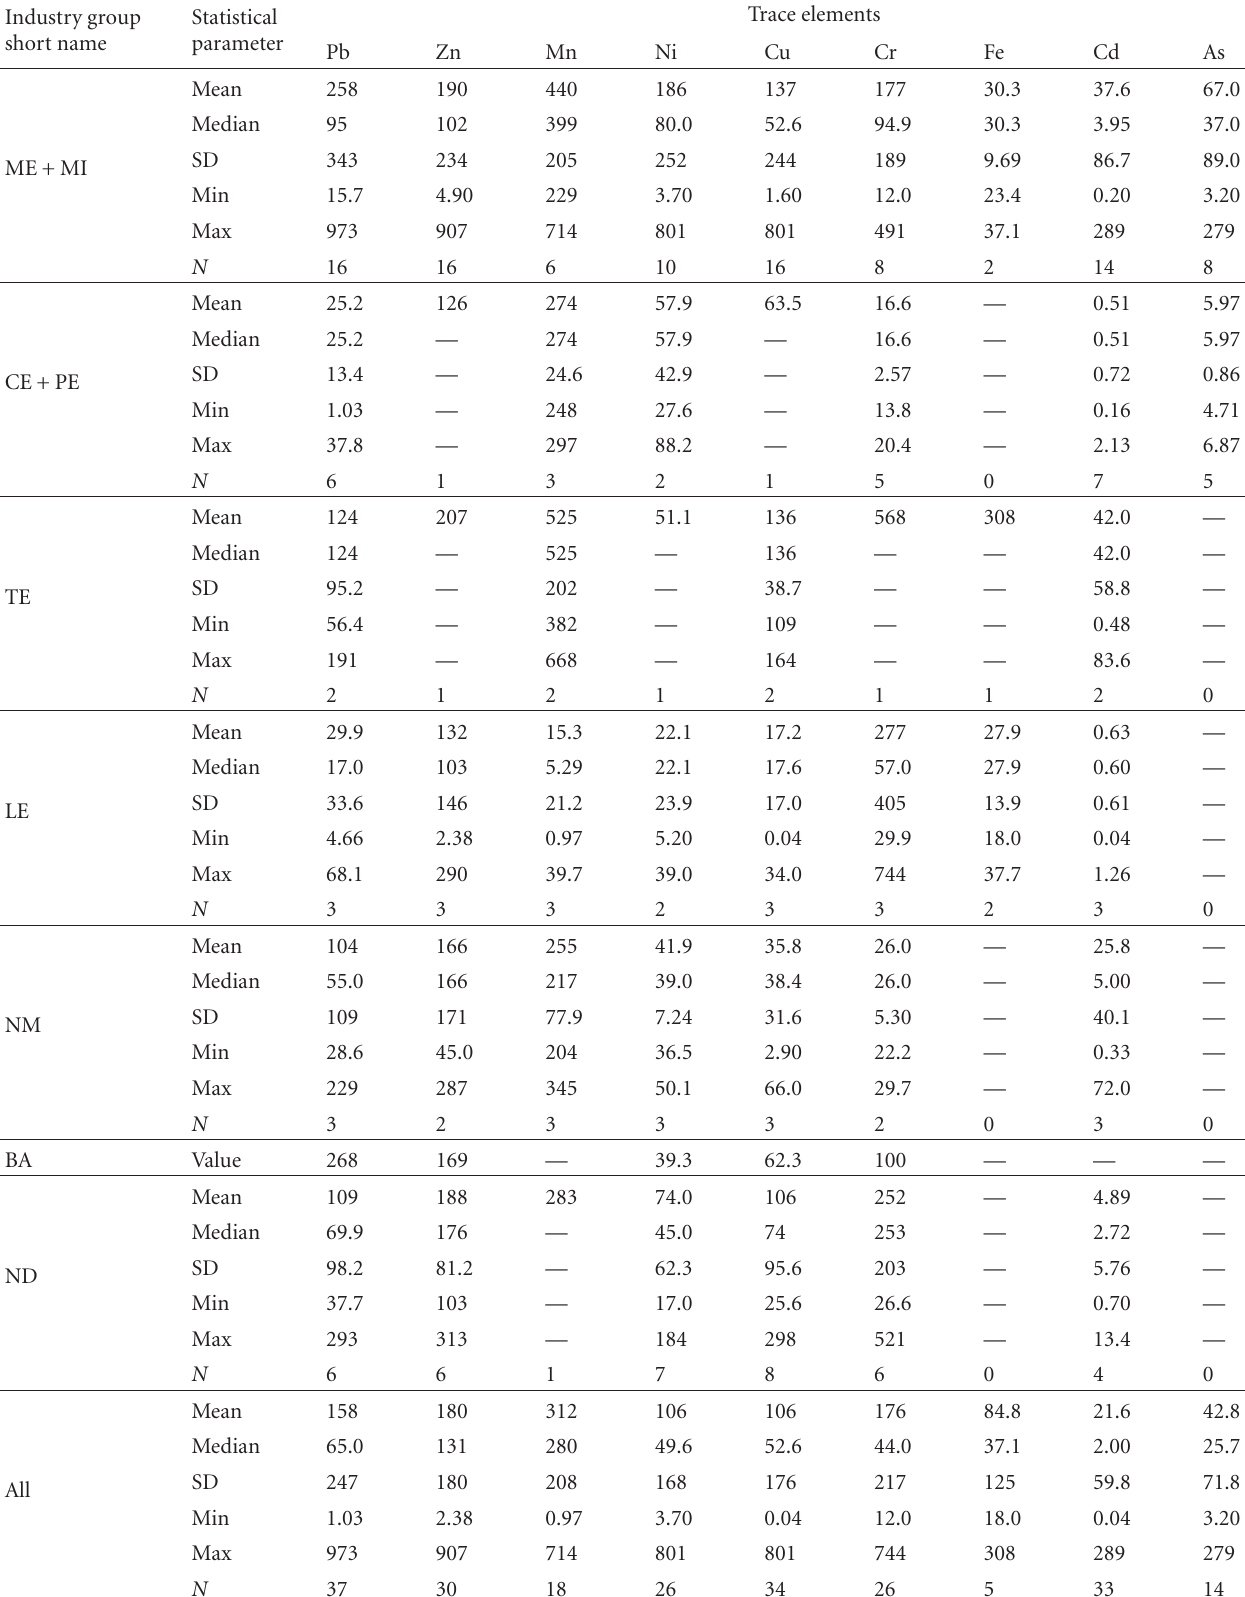
Table 5: Statistical summary of trace element concentration (in mg kg − 1 ) in soils a ff ected by industrial activities. Industry